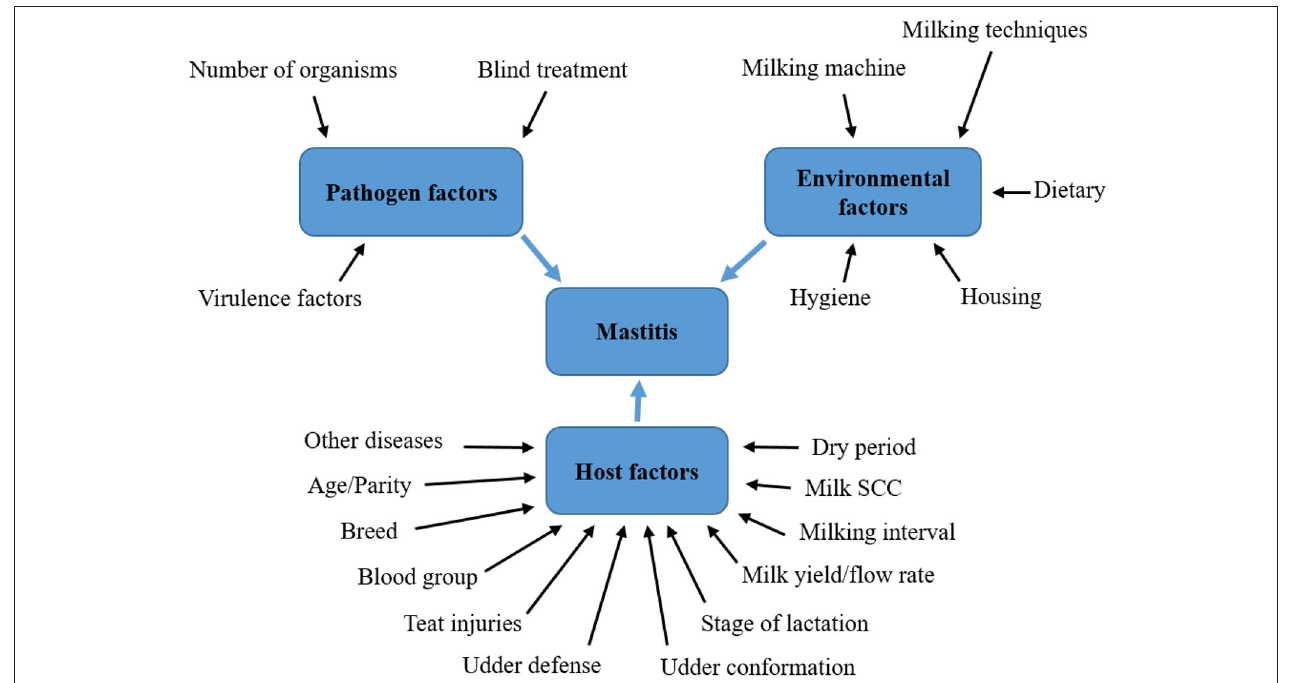
FIGURE 1 | Factors influencing the development of mastitis in dairy cows. Soure: Adapted from Abebe et al. (17).